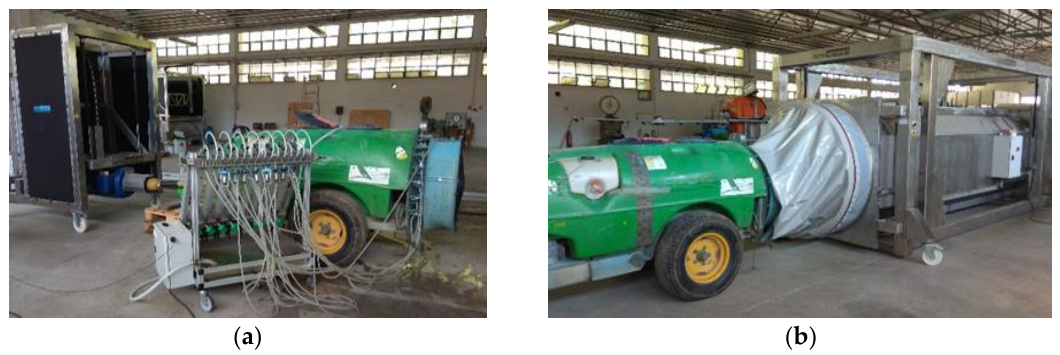
Figure 3. ( a ) Nozzles flow rate measurement; ( b ) fan air flow rate measurement.